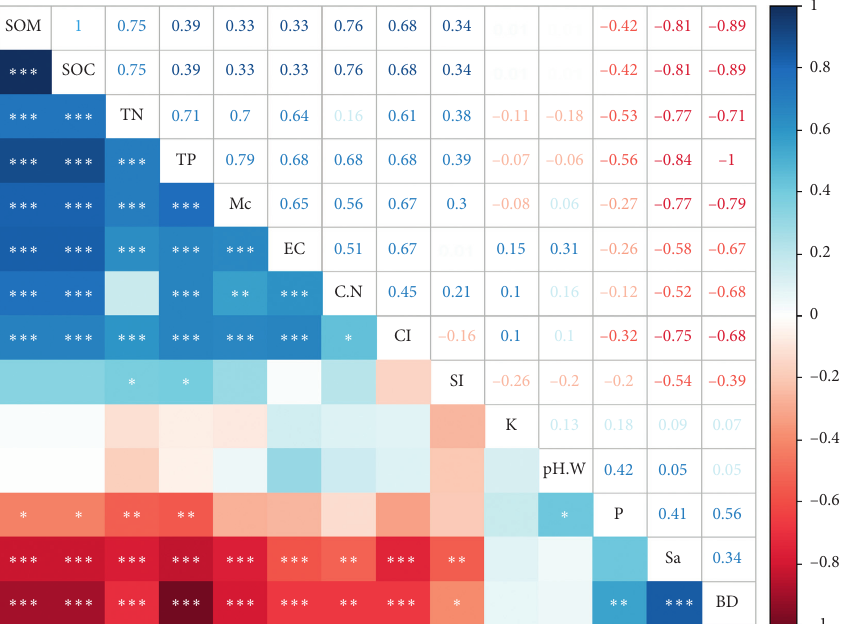
Figure 7: Pearson’s correlation matrix graph for selected soil physicochemical properties of the Ayiba watershed, northern Ethiopia (note: the correlation matrices present lower left in color and p values in asterisk and upper right in number (sampling depth 30 cm, n � 30). Positive correlations are displayed in blue, and negative correlations are in red color. Color intensity is proportional to the correlation coefficients, and ∗ , ∗∗ , and ∗∗∗ indicate significance at p < 0.05, p < 0.01, and p < 0.001,